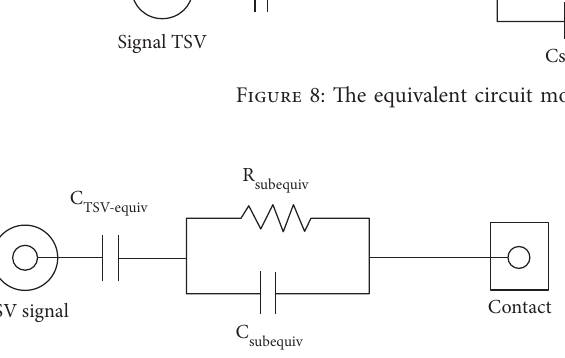
Figure 9: A simplified model of the TSV-active circuit noise coupling